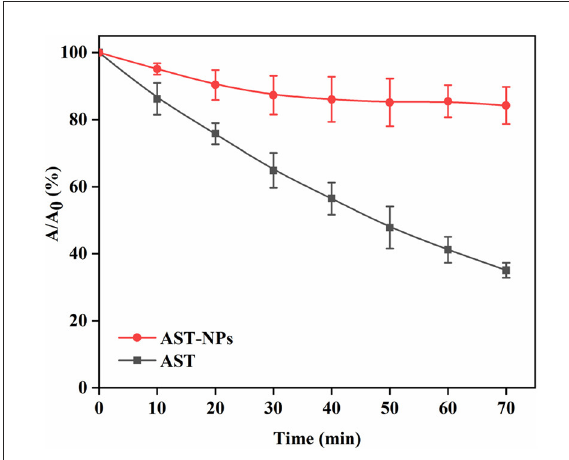
FIGURE6 Retention rate of AST-NPs and free AST under UV light.